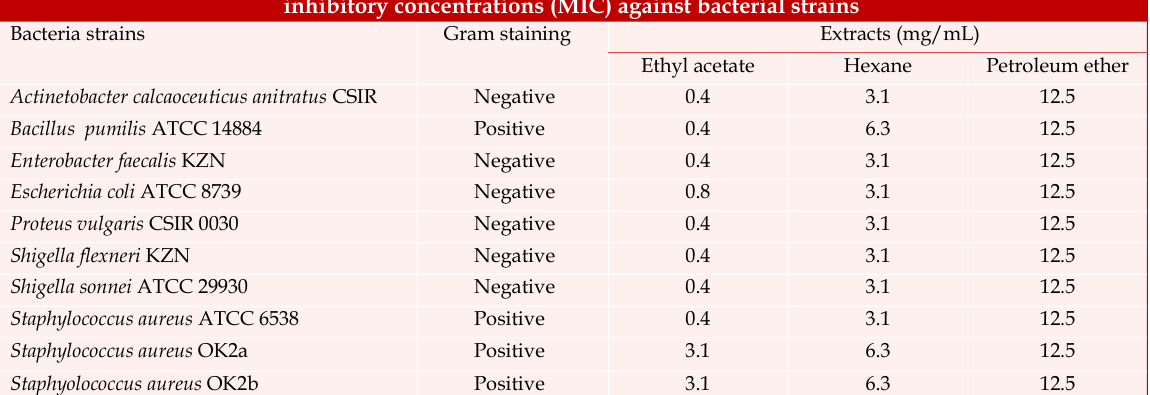
Antibacterial activity of fractions from Dianthus basuticus hydro-alcohol extract showing